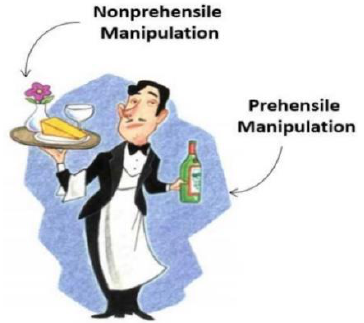
Figure 1. An example of prehensile and non-prehensile manipulations.